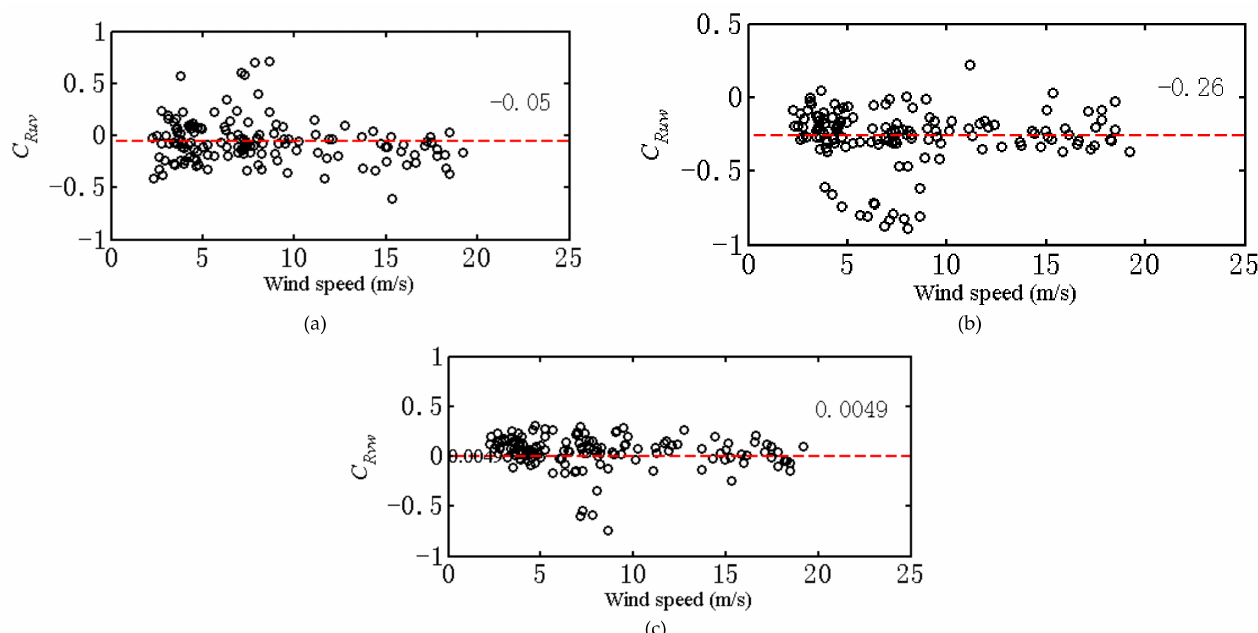
Figure 26. Correlation between the fluctuation wind speed at 80 m. ( a ) u and v directions; ( b ) u and w directions; and ( c ) v and w directions.